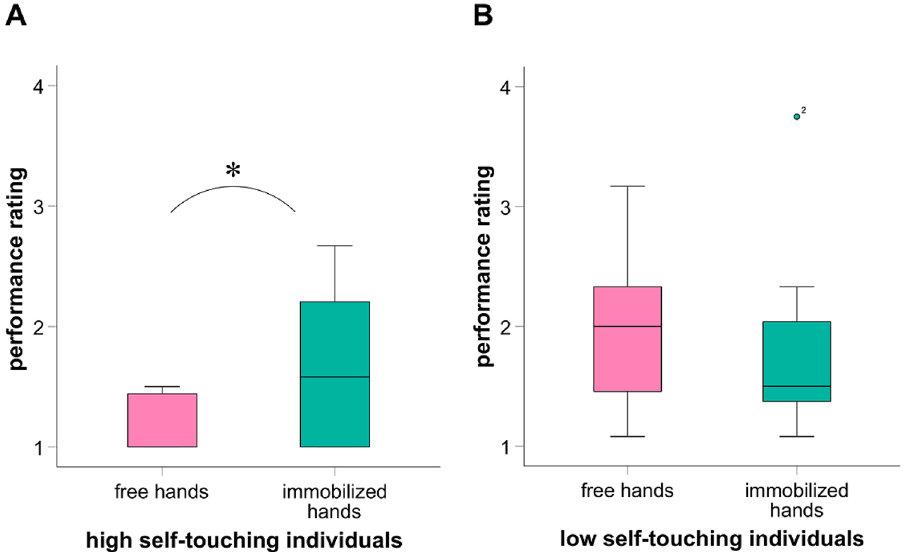
Figure 2. Performance ratings according to different experimental conditions (within-subjects). Score 1 represents the best outcome, score 4 represents the worst outcome. During “free hands” participants could move freely and perform spontaneous facial self-touches (sFST). During “immobilized hands” the performance of sFST was suppressed. Wilcoxon signed-ranked tests revealed that high self-touching individuals showed poorer performance outcomes when sFST were suppressed. * p <